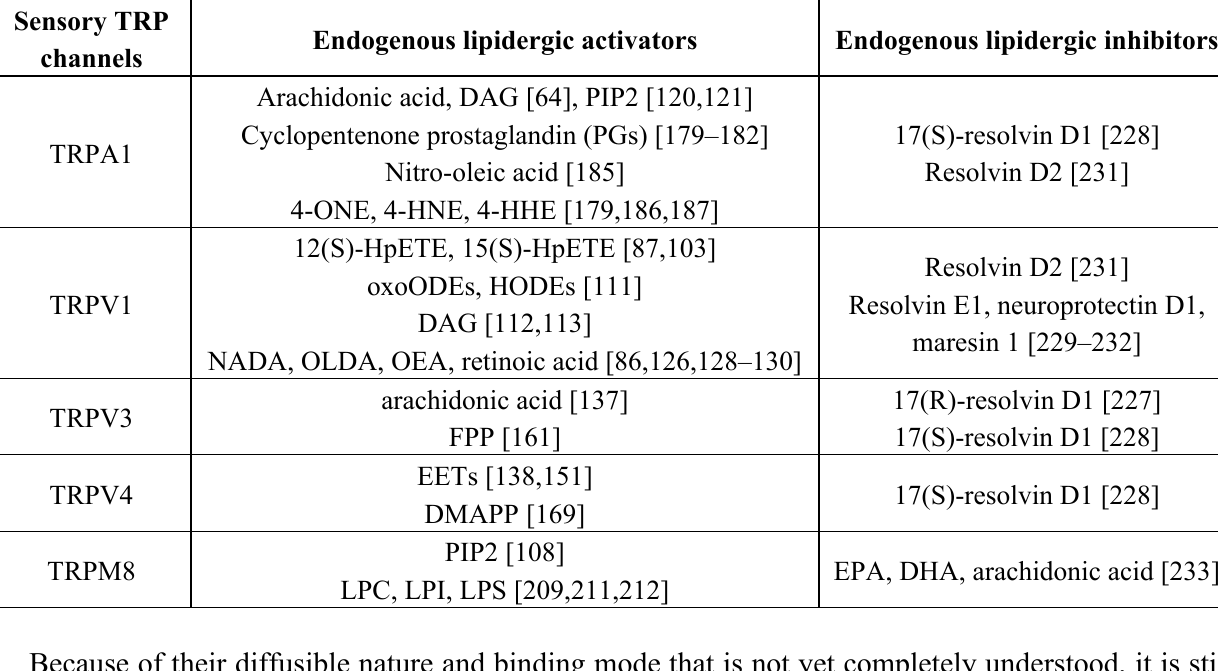
Table 1. The list of endogenous lipids that regulate sensory TRP channel activities introduced in this review and their TRP channel